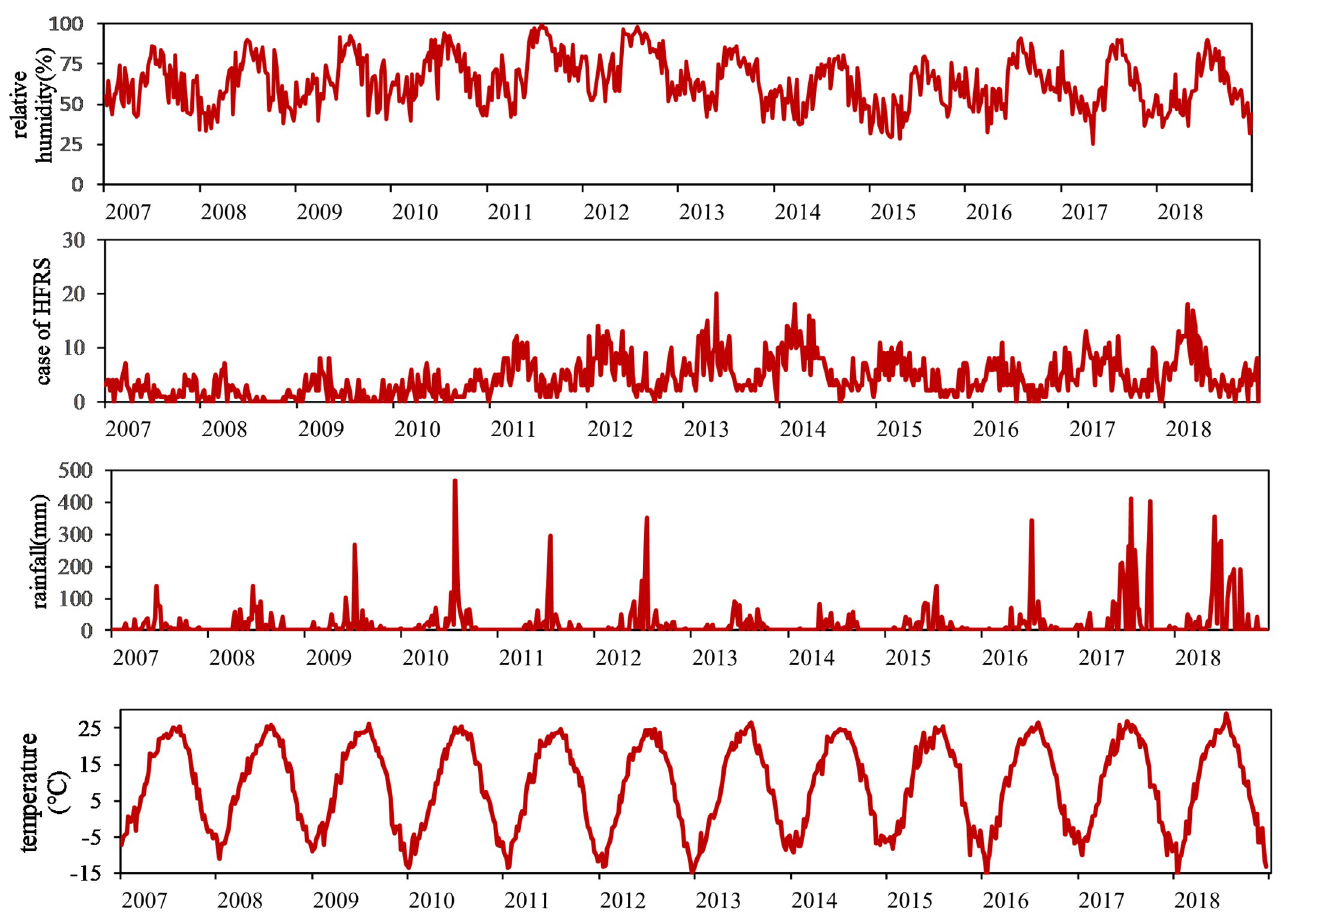
Fig 2. Time series plot of the HFRS cases and meteorological factors.